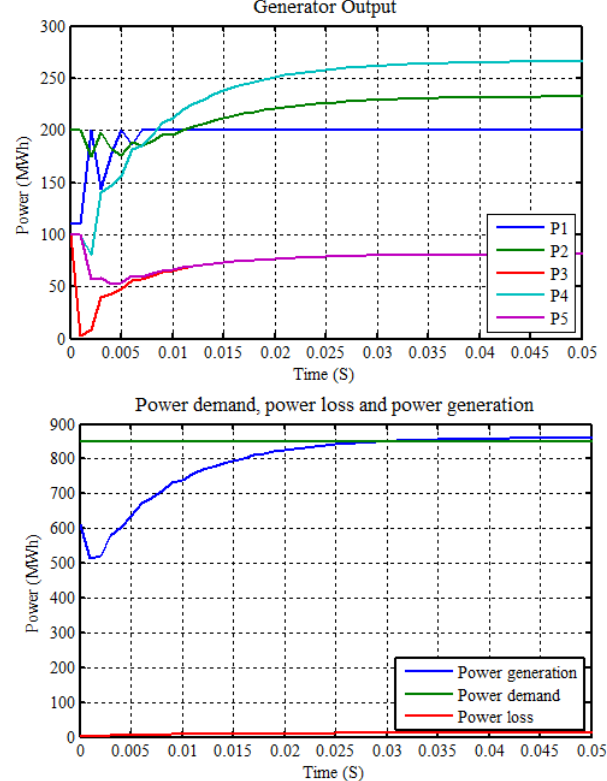
Figure 6. Case study 2: the power generation, power loss, and power demand.